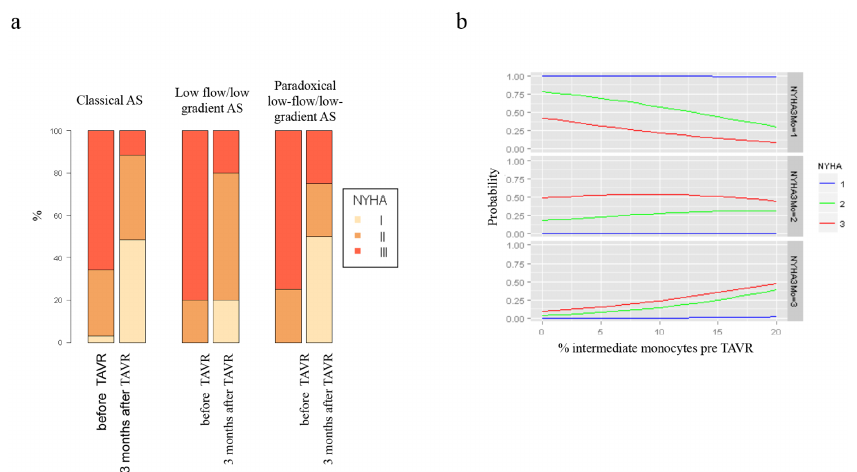
Fig 3. Functional capacities and intermediate monocytes. (a) Gain of functionalcapacitiesover time measuredby NYHA class split up for different AS entities. (b) Predicted probabilities to reach a specific NYHA class after three months for different percentages of the variableintermediate monocyte determinedbefore TAVR relative to class I chosen as baseline.NYHA classes before TAVR are depictedin blue: I; green: II; red: III.